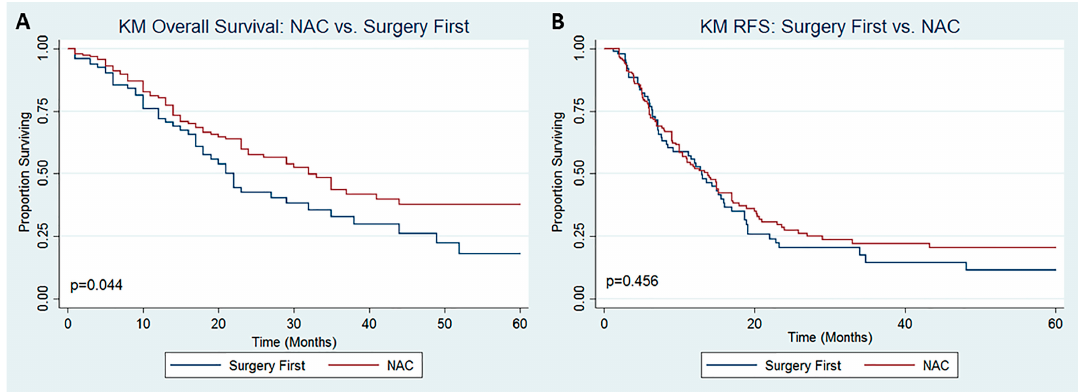
Figure 1. Kaplan–Meier Survival Analysis for ( A ) Overall Survival and ( B ) Recurrence-Free